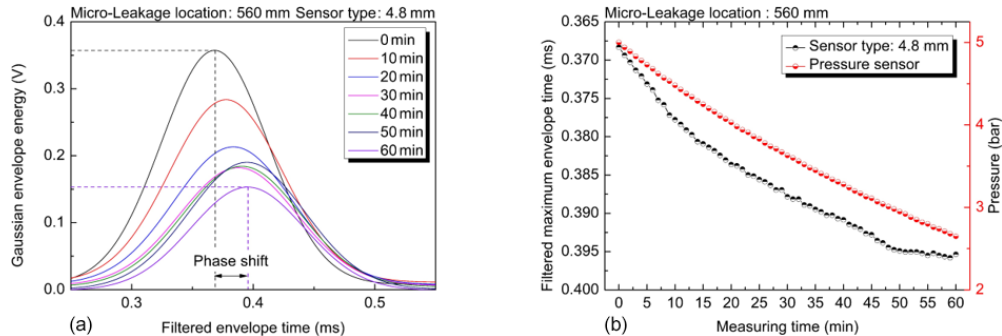
Figure 8. Phase shift of ultrasonic sensor envelope signal filtered through a Gaussian distribution for micro-leakage location of 560mm.